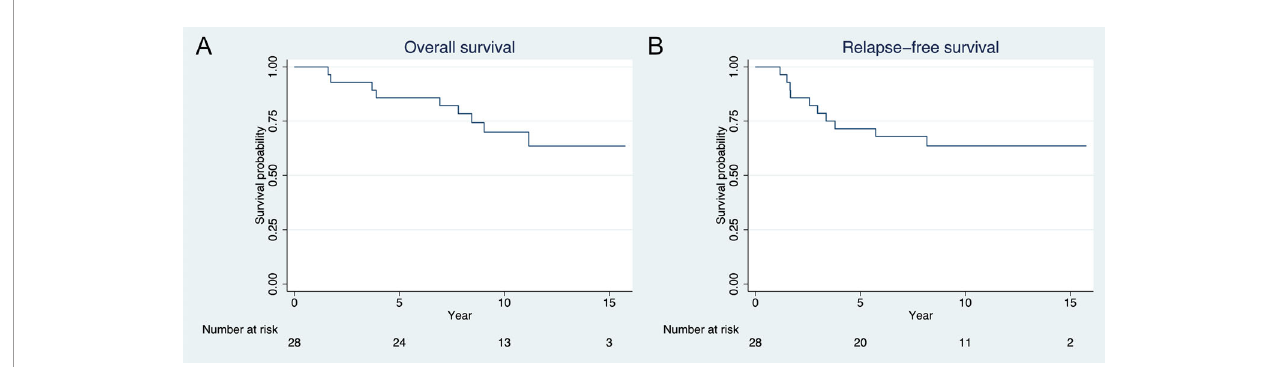
FIGURE 2 | Kaplan-Meier plot of (A) overall survival and (B) recurrence free survival. Three- and 5-year overall survival are 93% and 86%, respectively. Three- and 5-year relapse-free survival are 79% and 71%,